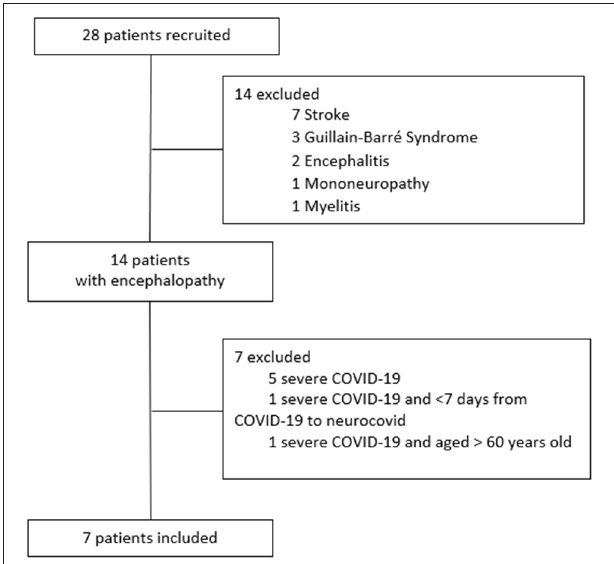
FIGURE 1 | Patients flow-chart. neurocovid, neurological manifestations of COVID-19. Encephalopathy was defined according to the Ellul et